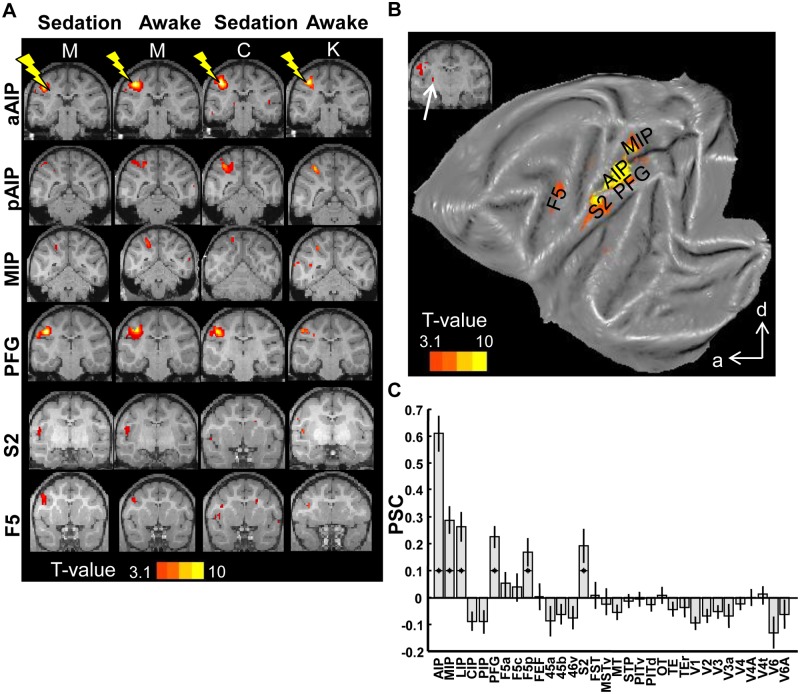
Microstimulation of area aAIP.A. T-score maps for the contrast EM-NoEM, for individual animals, represented on coronal sections (template anatomy). Leftmost columns show data for monkey M in the sedated and awake states, respectively; rightmost columns show results for monkeys C and K. See files aAIP* in [25]. B. T-score maps for the contrast EM-NoEM, group data, represented on a flat map. a: anterior; d: dorsal. C. Percent signal change calculated in the predefined ROIs. * p < 0.05; corrected for multiple comparisons (32 ROIs). Black lines indicate standard error of the mean.